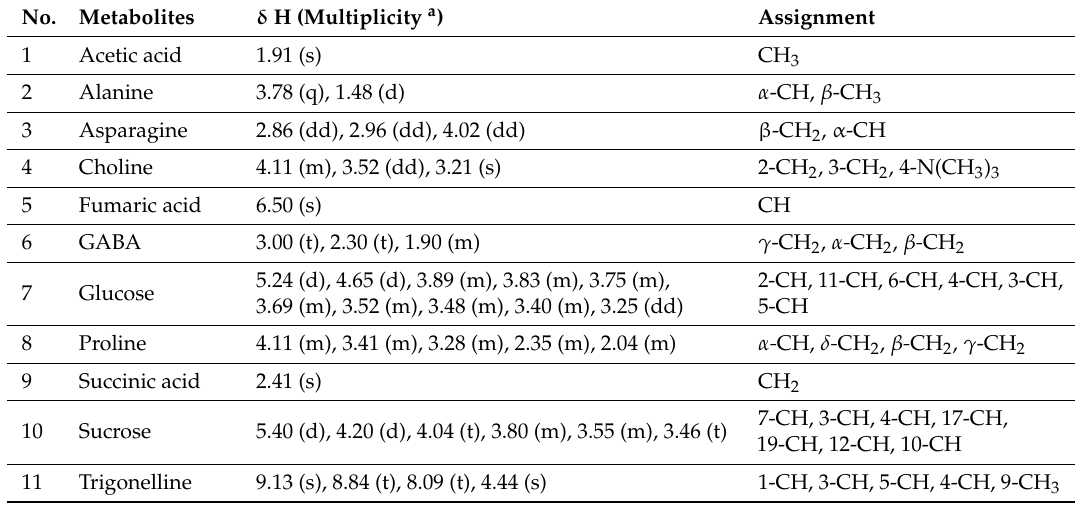
Table 2. The linear regression equations, LOD and LOQ for 11 metabolites ( n = 3).